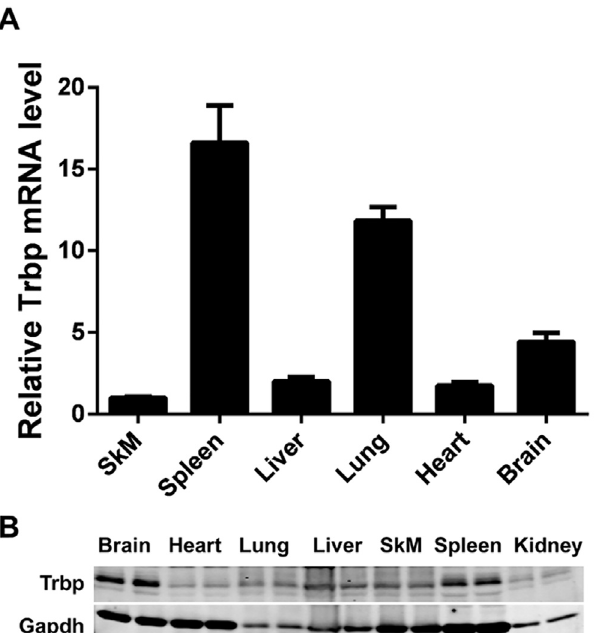
Fig 1. Expression of Trbp in mouse tissues. (A) Expression of Trbp mRNAs in skeletal muscle (SkM), spleen, liver, lung, heart and brain tissues of adult mice as detected by qPCR assays (n = 3); (B) Western blots detecting the expression of Trbp proteins in brain, heart, lung, liver, skeletal muscle (SkM), spleen and kidney tissues of adult mice.